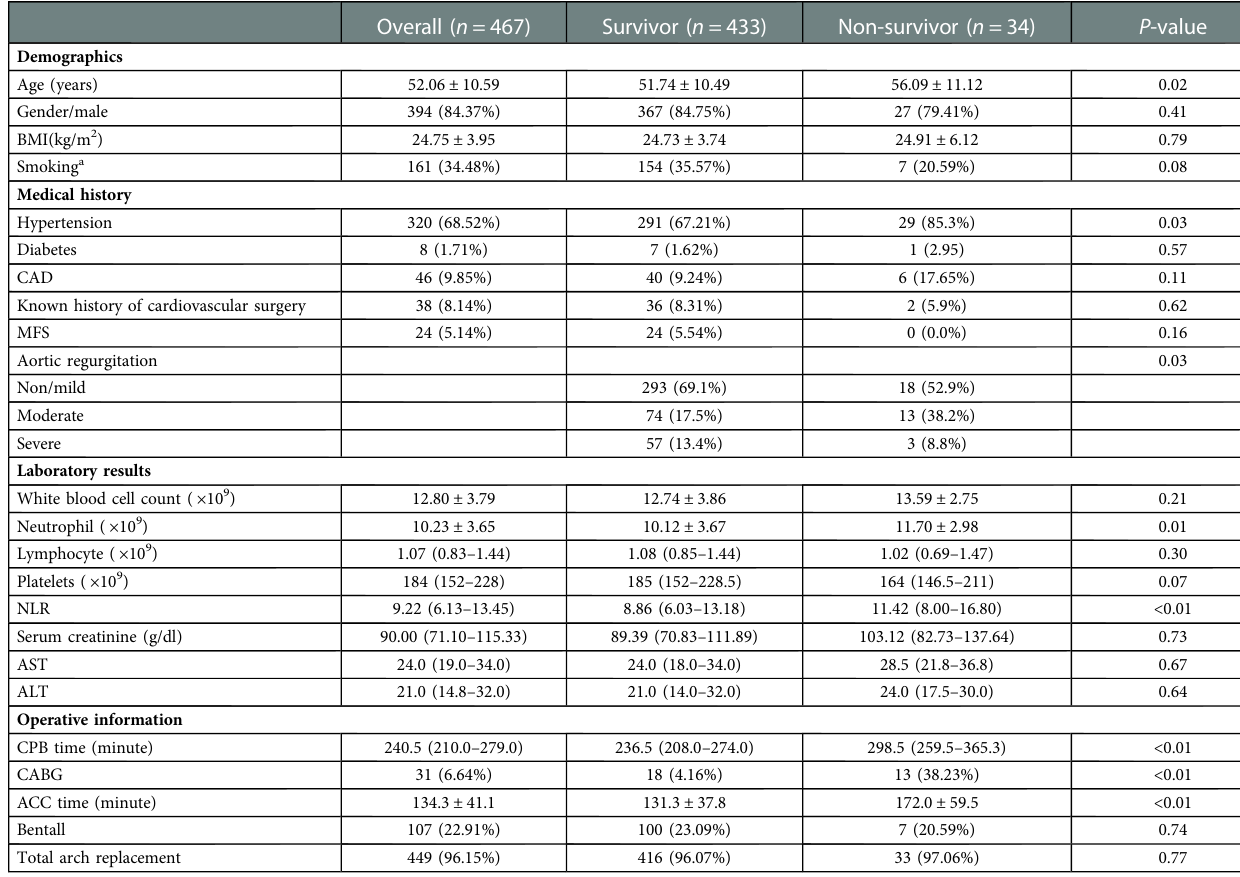
TABLE 1 Baseline characteristics of clinical data in